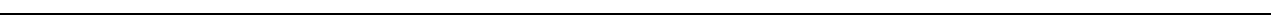
Fig. 2 Gene expansion in G . elata and microbial community analysis. a REViGO semantic similarity scatter plot of Biology Process Gene Ontology terms for expanded genes in G . elata . In semantic spaces, the proximity between circles represents relatedness (similarity) of the GO terms. Similar GO terms are close together in the plot. The axes in the plot have no intrinsic meaning, but were used to measure pairwise similarities between GO terms. Color indicates degree of enrichment for each process presented as the p -value from the hyper-geometric test. b The draft mitochondrial genome of G . elata . Nineteen contigs are manually displayed as a circle, including 12 circular contigs in orange (ornamented with stars) and 7 linear contigs (in blue). The genes are indicated in the middle circle, and are color coded as follows: trn (blue), rrn (light blue), atp (red), and other protein-coding genes (black). The duplicated atp genes and their fragments are detailed in the inner circle. The duplicated genes are suf fi xed with ‘ b ’ , and the gene fragments are suf fi xed with ‘ fragment ’ . c Gene expression heat map of the normalized RNA-Seq data for genes encoding the monocot mannose-binding lectin antifungal proteins (GAFP) in G . elata 16 . The units indicate the expression levels of different gene members of GAFP in the protocorm, juvenile tuber, immature tuber, mature tuber, and scape of G . elata (only shown where the gene expression level RPKM > 1, n = 3). d Venn diagrams showing the number of shared and unique fungal and bacterial operational taxonomic units (OTUs) based on the ITS and 16S sequence analyses in protocorms, juvenile tubers, immature tubers, and mature tubers of G . elata . OTUs showed the composition and abundance of the microbe species, which were de fi ned at 3%